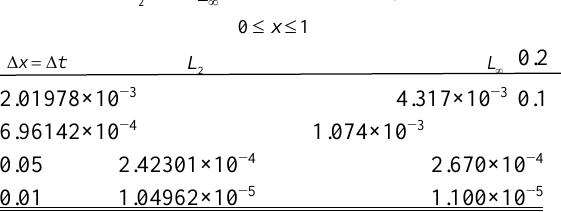
Table 2. L and L error norm when 10  h 2 